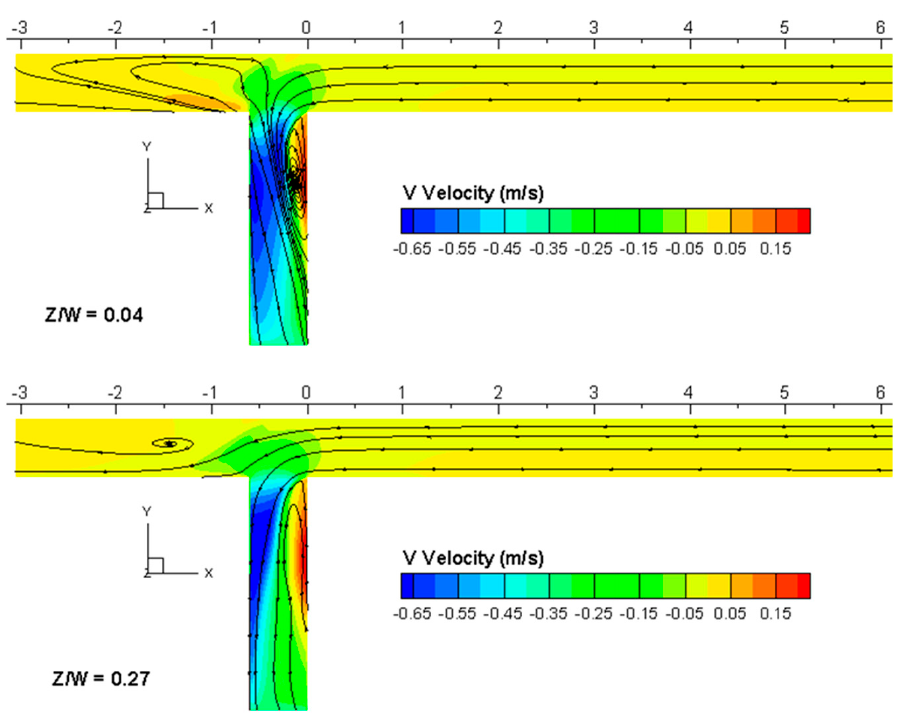
Figure 6. Simulated v-velocity contours and flow streamlines at two horizontal planes; the top figure is near the bed and the bottom one is near the free surface.